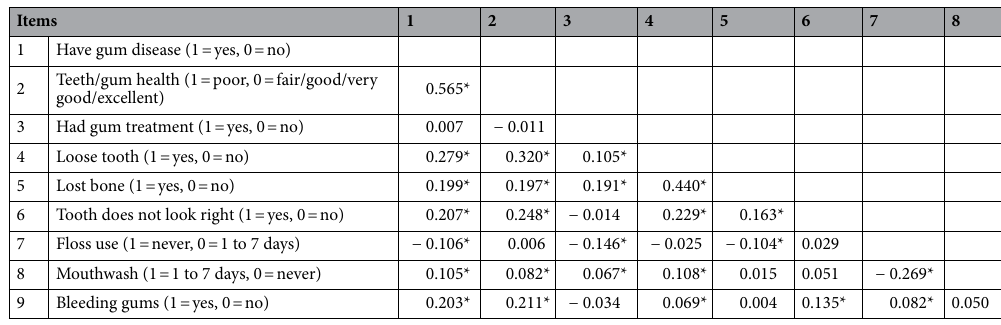
Table 3. Correlations between pair-wise dichotomized periodontitis questionnaire items. Kendall’s Tau-b correlation coefficients are presented. * p <